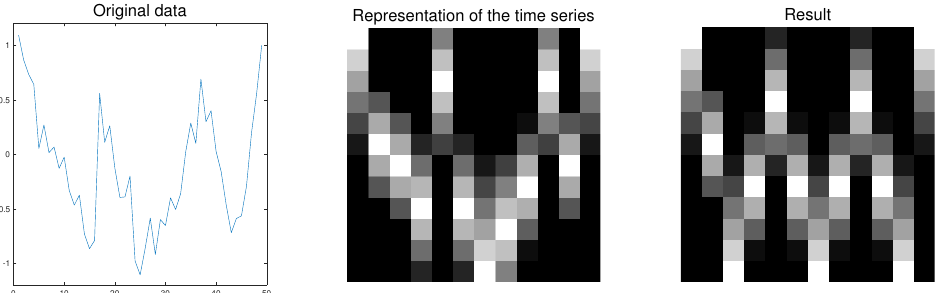
Figure 12. The N-equal-part method, the middle subgraph is the the input of the LAHN and the third subgraph is the matching